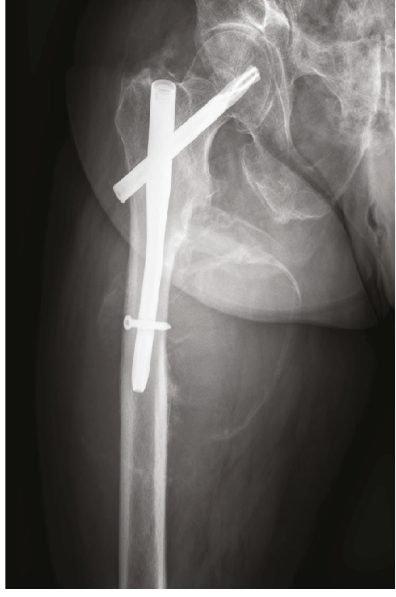
Figure 3: Plain X-rays eight months postoperatively showed the presence of a medial mass centred over the distal locking screw with calci fi cation of the peripheral borders, suggestive for an (infected) hematoma. Compression and severe osteolysis of the medial border of the femur were